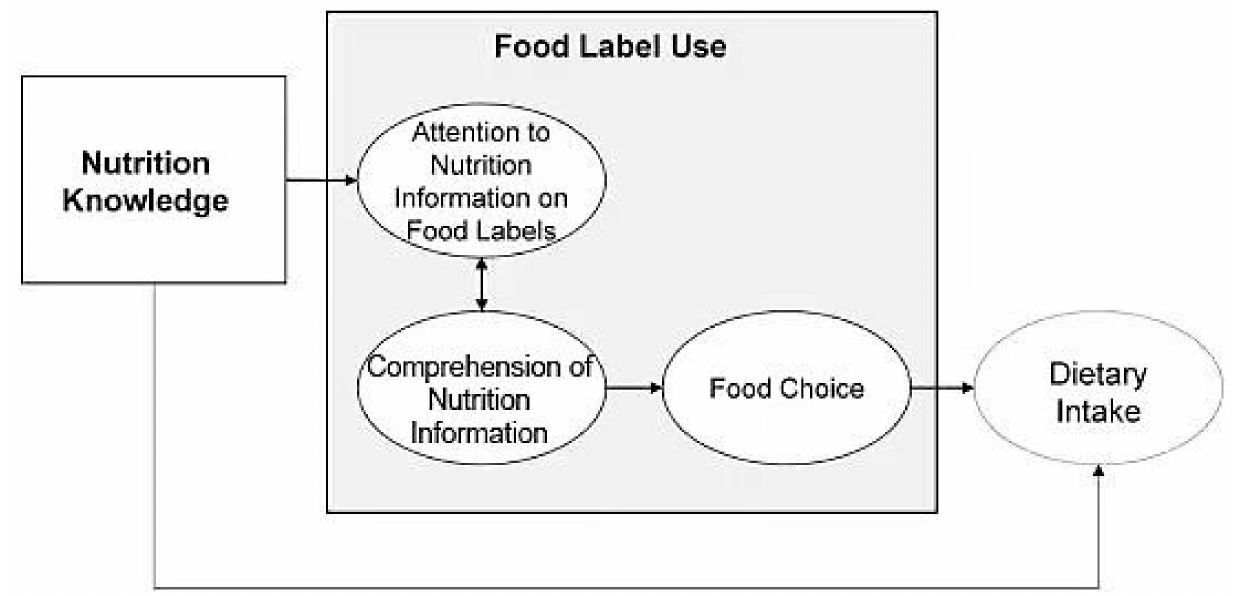
Figure 1. The Cognitive Processing Model. Source: Miller and Cassady